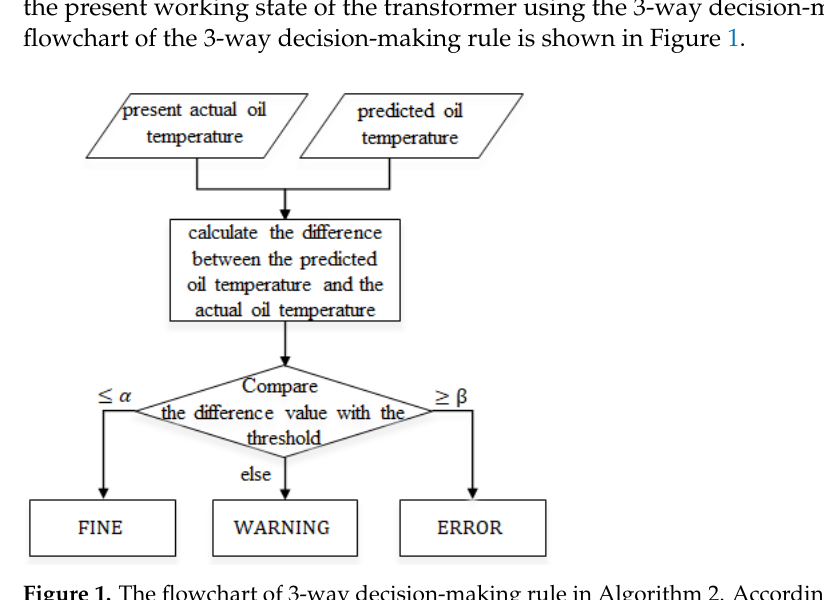
Figure 1. The flowchart of 3-way decision-making rule in Algorithm 2. According to the difference between the predicted oil temperature and actual oil temperature, the 3 transformer states FINE, ERROR, and WARNING were obtained.